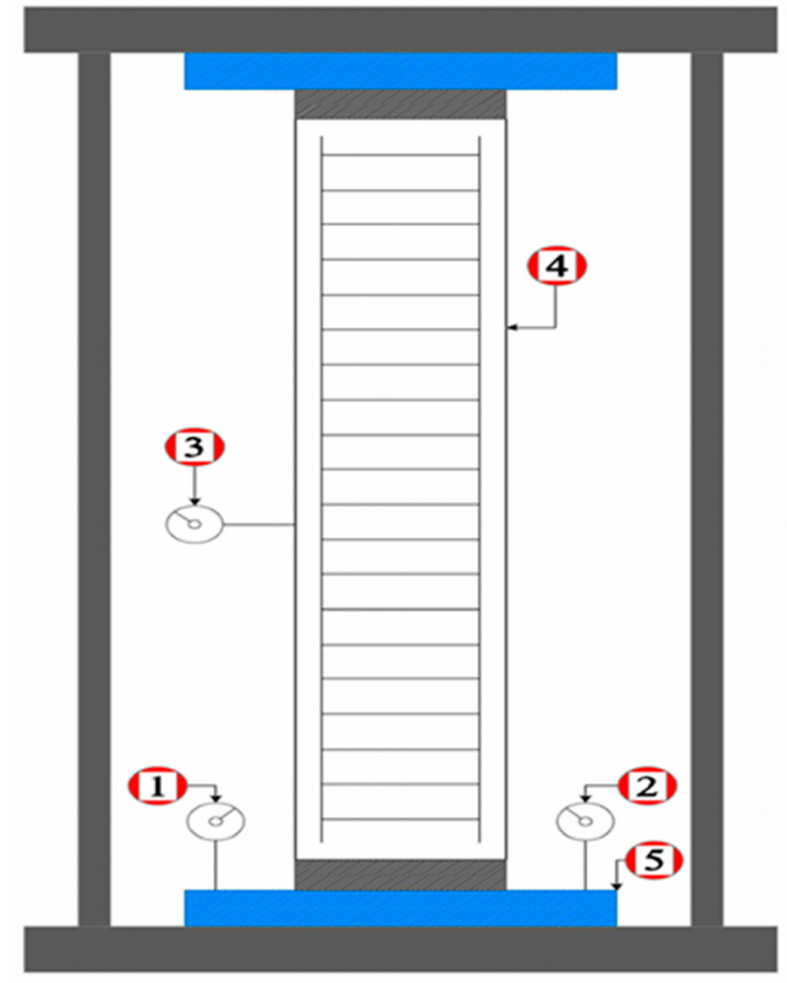
Figure 3. The instrumentation setup to measure deformations in columns. The dial gauges 1 and 2 were installed for axial deformation, and 3 for lateral deformation measurements. The label 4 represents column specimen, while the base plate is marked with label